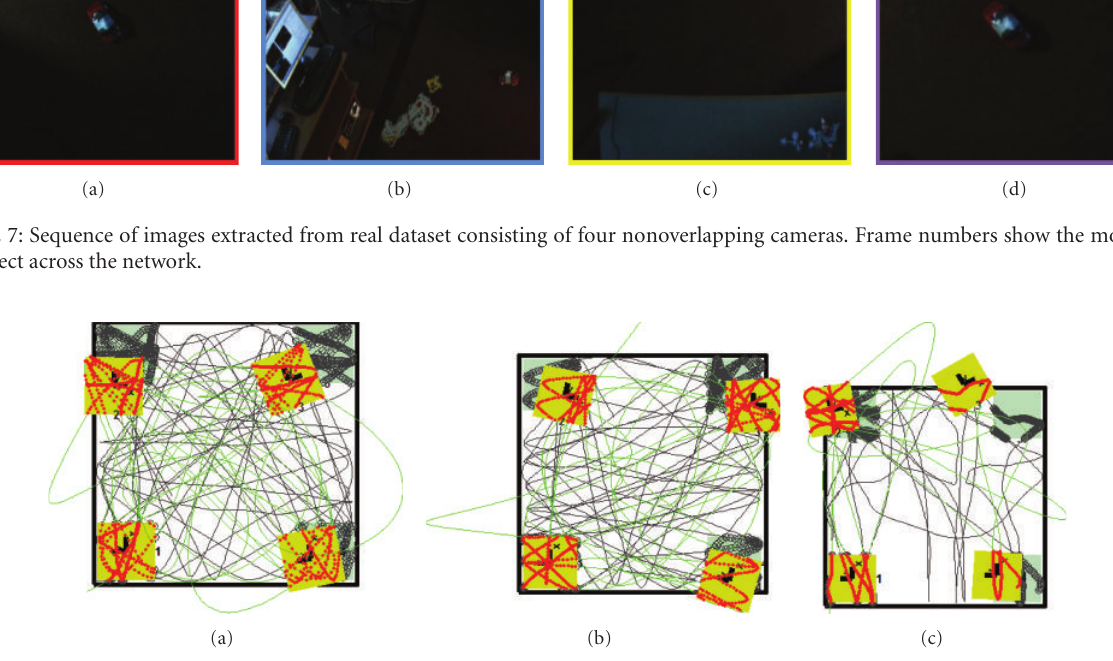
Figure 8: CLUTE localization results for the 4-camera network. Yellow squares are the estimated localization and green lines indicate the e6stimated trajectory in the unobserved areas. (a) Experiment 1 dataset; (b) experiment 2 dataset; (c) experiment 3